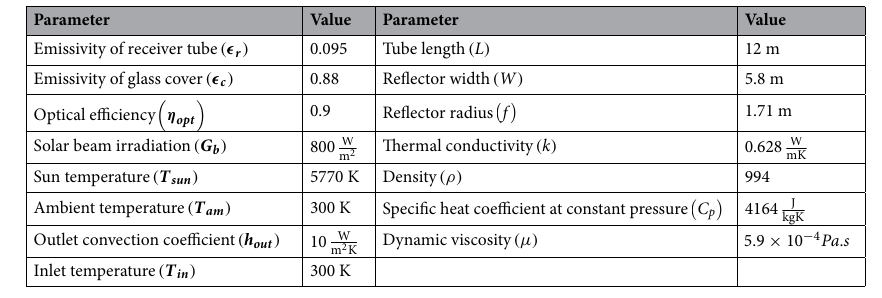
Table 2. Baseline design 7 .